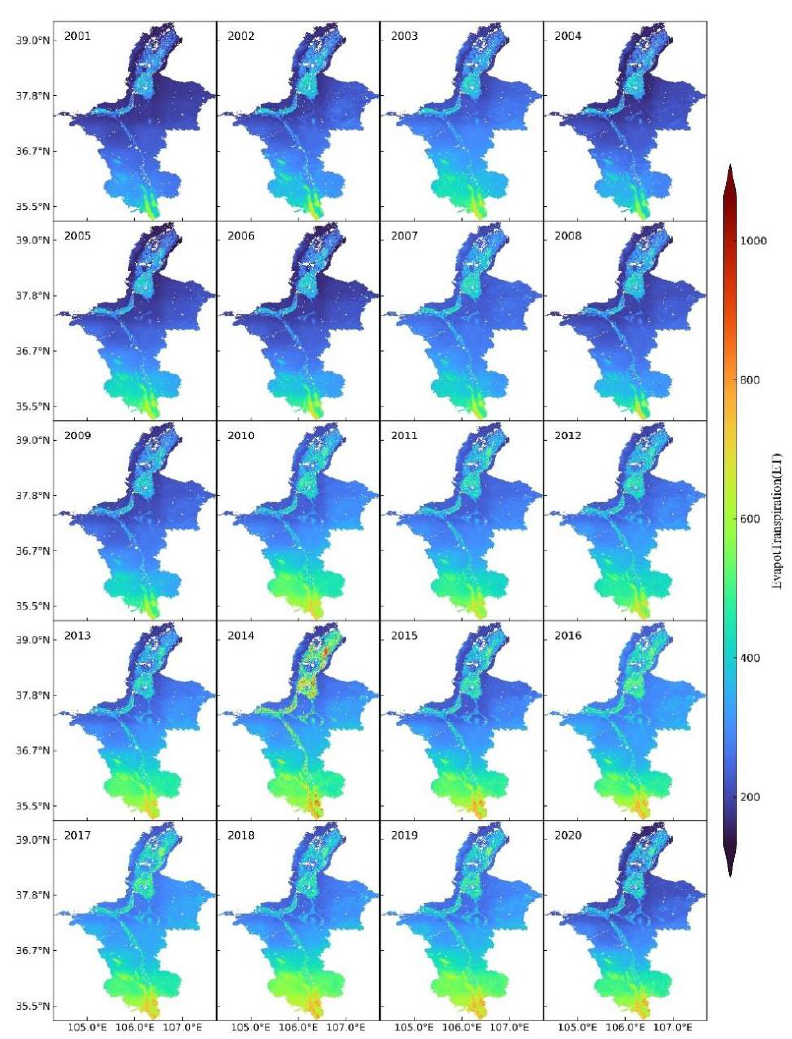
Figure 4. Spatial distribution of annual ET in Ningxia from 2001 to2020.